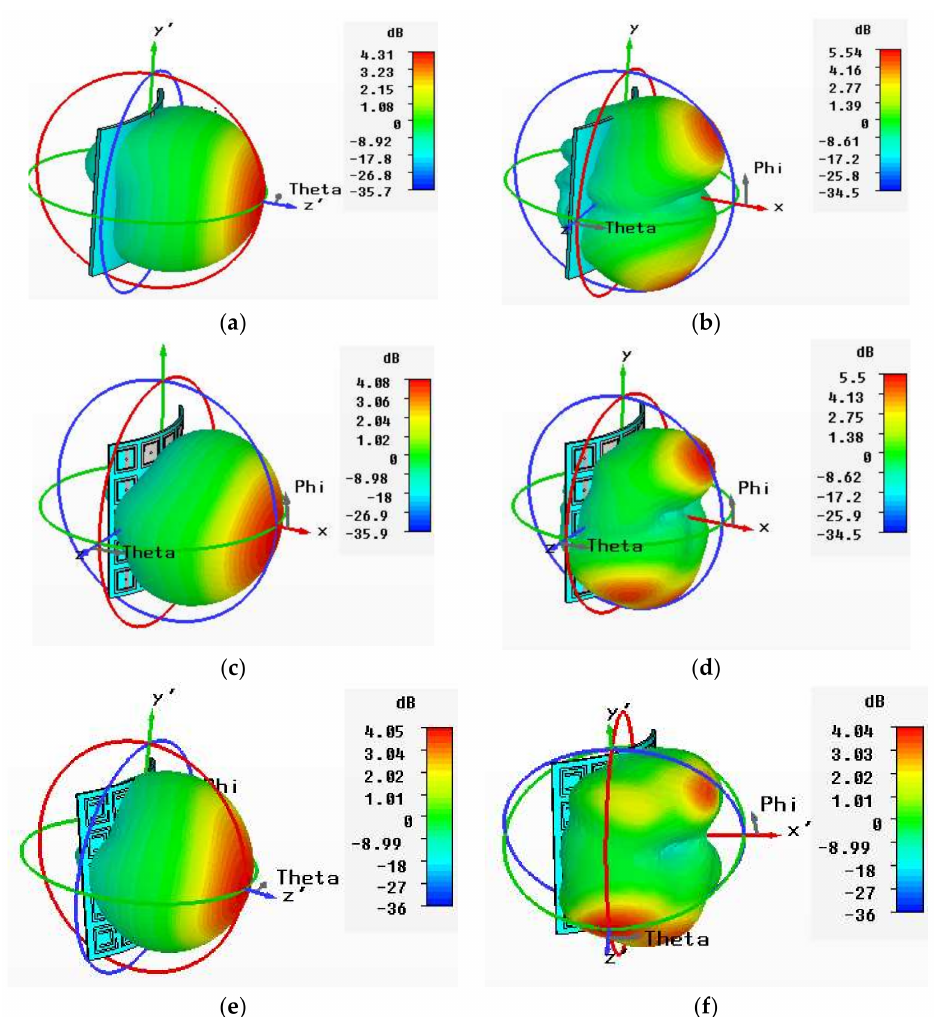
Figure 17. 3D radiation pattern of bent scenario (free space). ( a ) Conventional antenna at 2.4 GHz. ( b ) Conventional antenna at 5.4 GHz. ( c ) EBG-based antenna at 2.4 GHz. ( d ) EBG-based antenna at